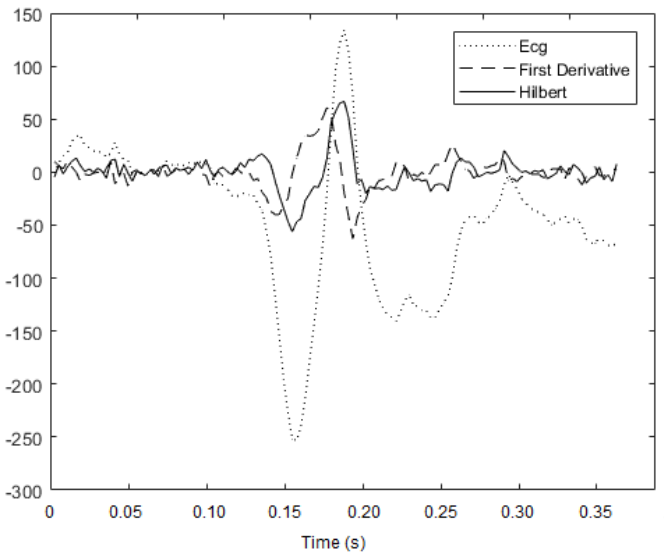
Figure 2. Details of processed signal at stage 1 and 2.